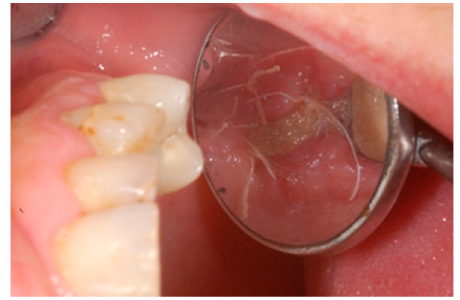
Figure 7. Occlusal intraoperative view of the oral mucosa 10 days after tooth extraction and socket preservation. The exposed membrane was covered by a fibrin layer. Sound margins of the wound are visible.